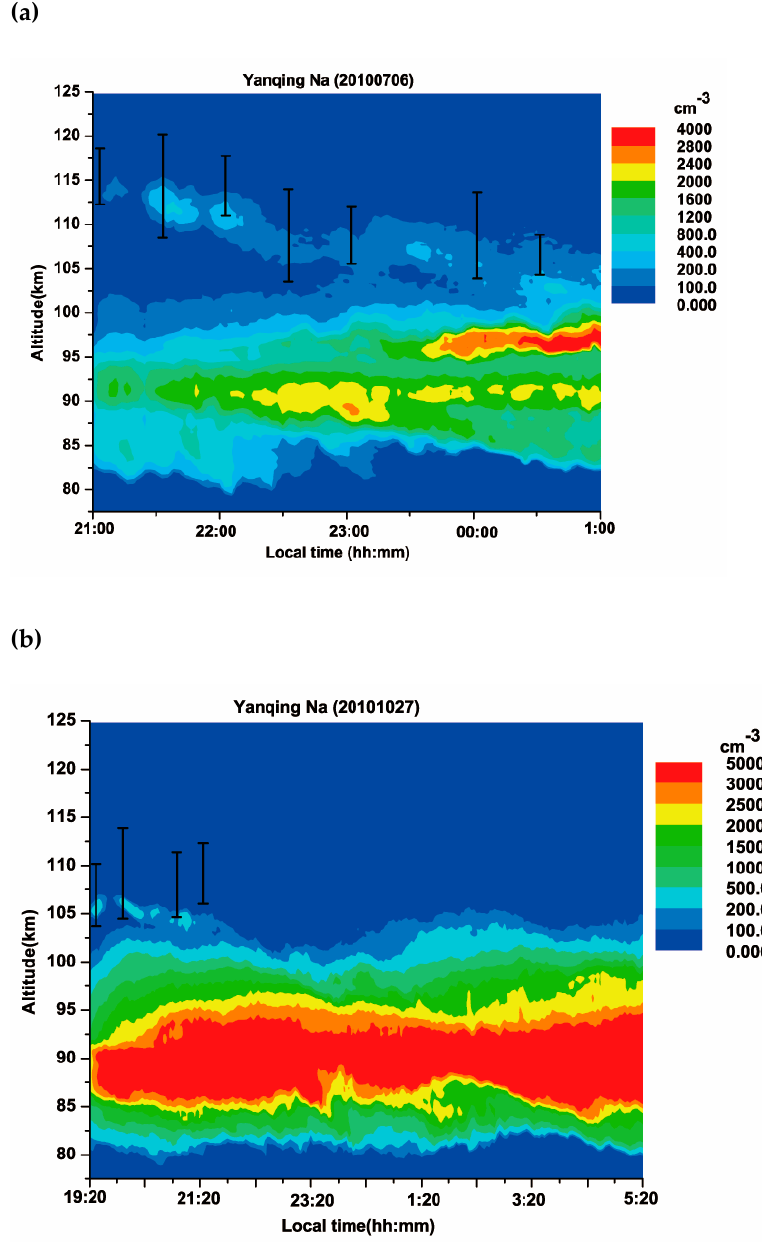
Figure 6. The evolution of the sodium densities and Es on ( a ) 6 July 2010 and ( b ) 27 October 2010. The pseudo color image demonstrates the density evolution of sodium. The central height of the black bar shows the height of the Es, and the length demonstrates the critical frequency of the Es (1 km represents 0.5